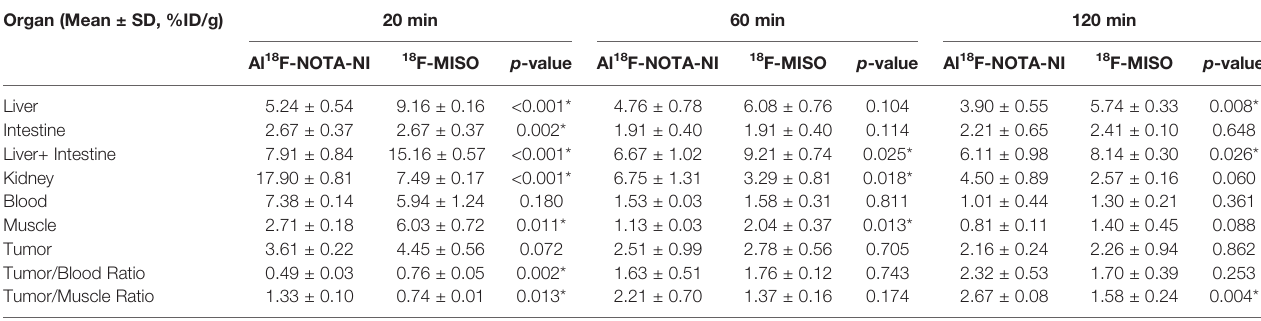
TABLE 2 | Organ uptake, tumor uptake, tumor/blood ratio and tumor/muscle ratio of Al18F-NOTA-NI and 18F-MISO. Organ (Mean ± SD,